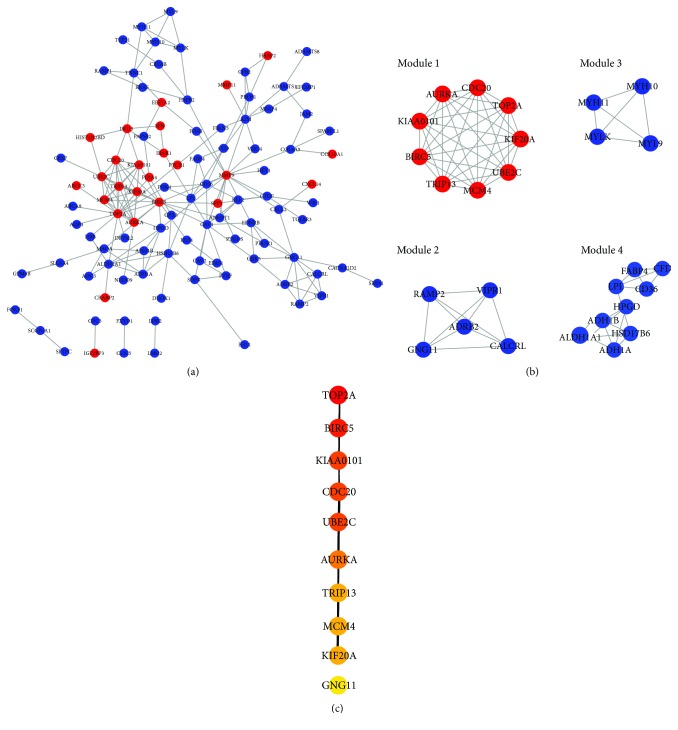
PPI network construction. (a) PPI network: the red nodes represent upregulated DEGs and the blue nodes represent downregulated DEGs. (b) 4 modules were extracted by MCODE. (c) The top 10 hub genes were chosen by cytoHubba, and the more forward ranking is represented by a redder color.